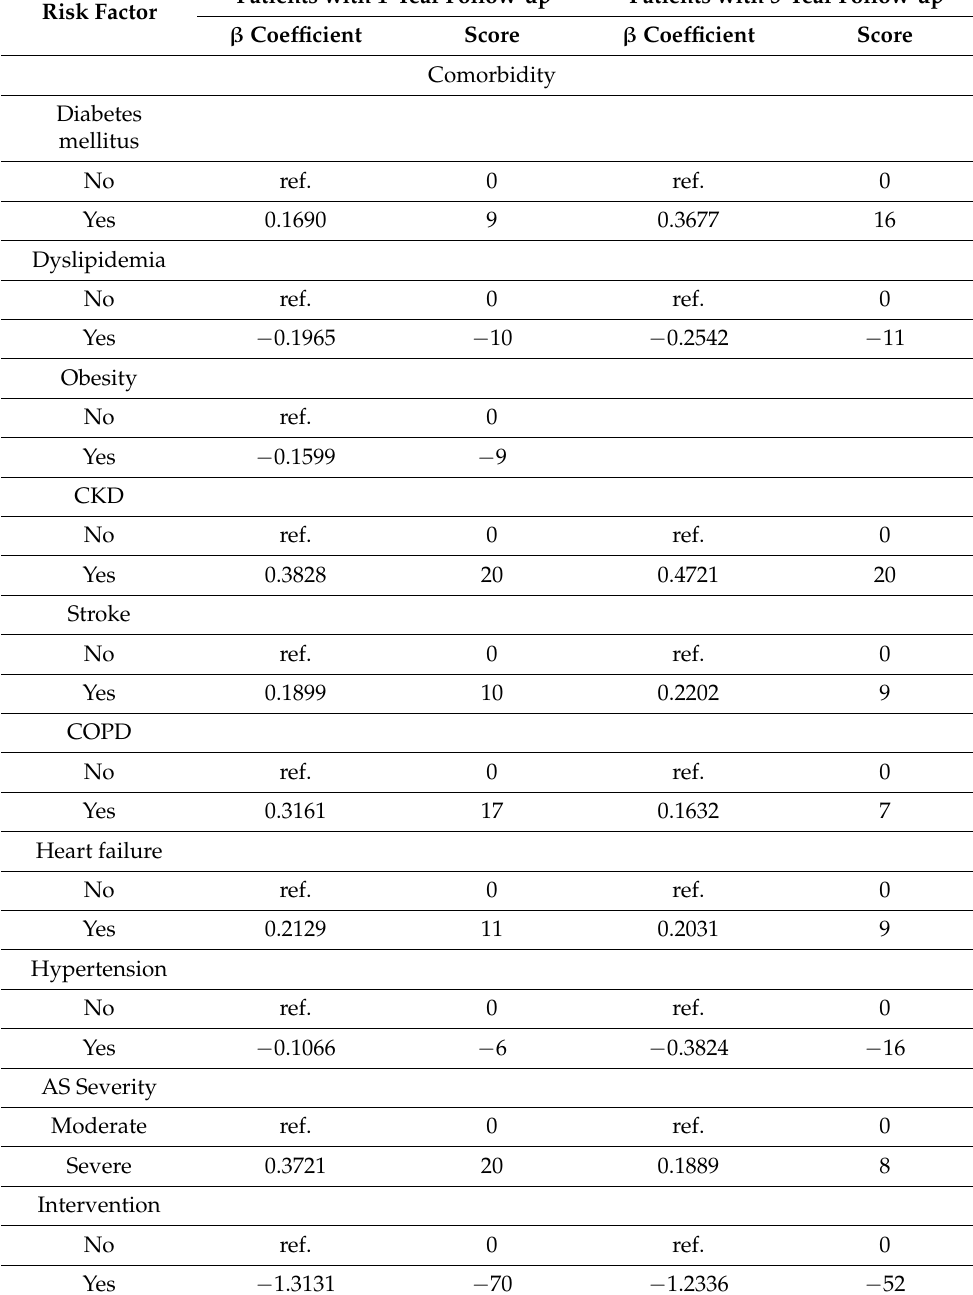
Table 3. Cont. Patients with 1-Year Follow-up Patients with 5-Year Follow-up Risk Factor β